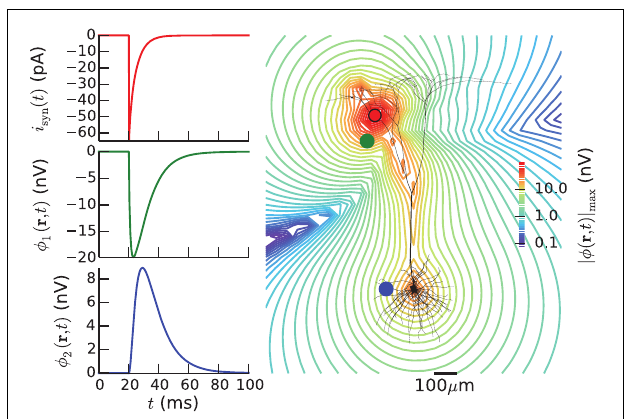
FIGURE 3 | Extracellular potential generated by a single synaptic input produced by executing example1.py . Extracellular potentials ( middle and bottom left panels) generated at positions marked by green and blue dot, respectively, by a synaptic input current ( upper left panel) injected in the apical dendrite at the position marked by red dot. The pyramidal cell corresponds to a layer-5 pyramidal cell from cat visual cortex with passive membranes but without adjustment of the membrane area to compensate for spines (Mainen and Sejnowski, 1996). The contour plot shows equipotential lines for the maximum magnitude of the extracellular potential in the xz